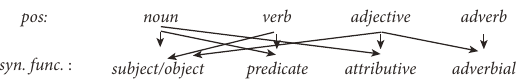
Figure 5: Mapping between pos and syntactic functions in Chinese. Figure 6: Zhu’s compositionality of Chinese